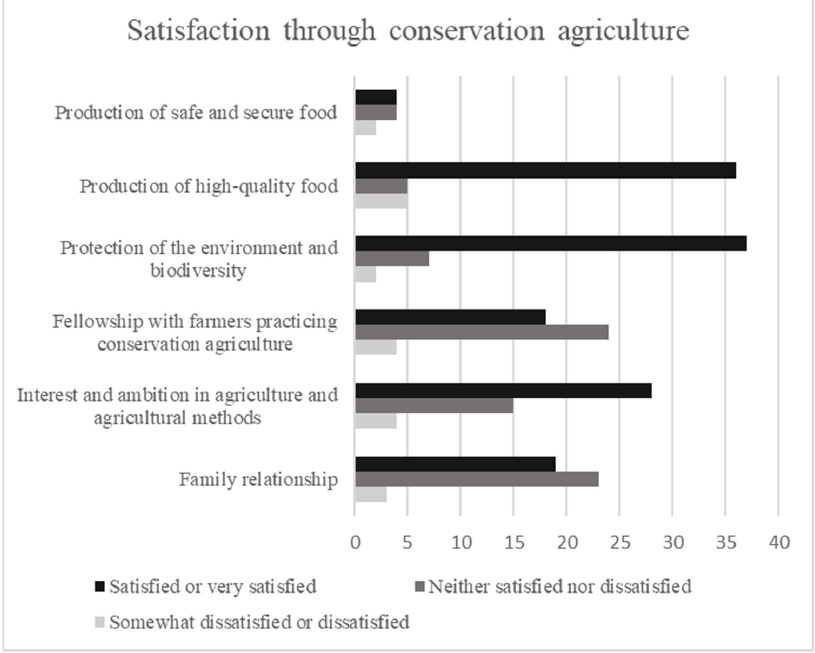
Figure 3. Ishikawa Prefecture farmers’ satisfaction through conservation agriculture.